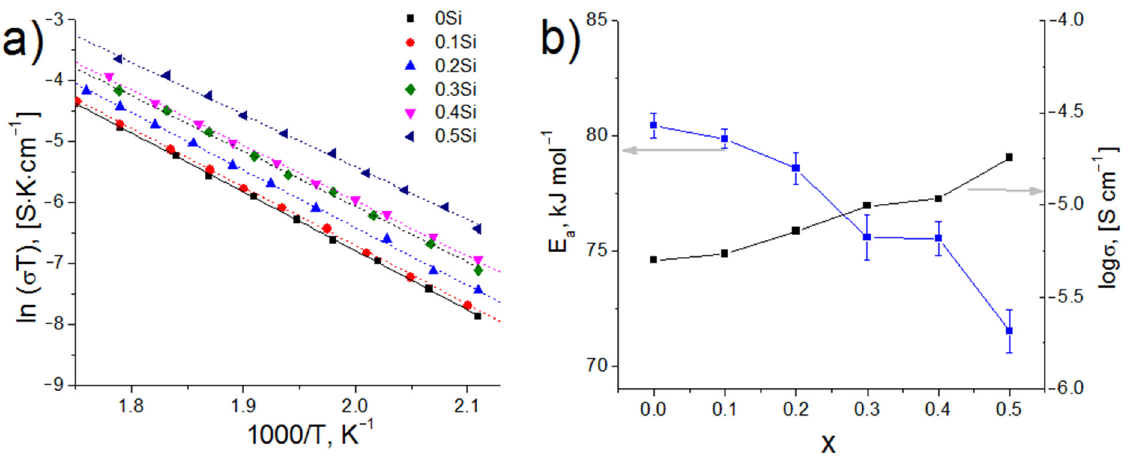
Figure 8. Arrhenius plots of the conductivity for 0Si-0.5Si glasses ( a ) and composition dependences of the E a (blue) and conductivity (black) of Li 1.5+ х Al 0.5 Ge 1.5 Si x P 3 − x O 12 glasses at 250 °C ( b ).